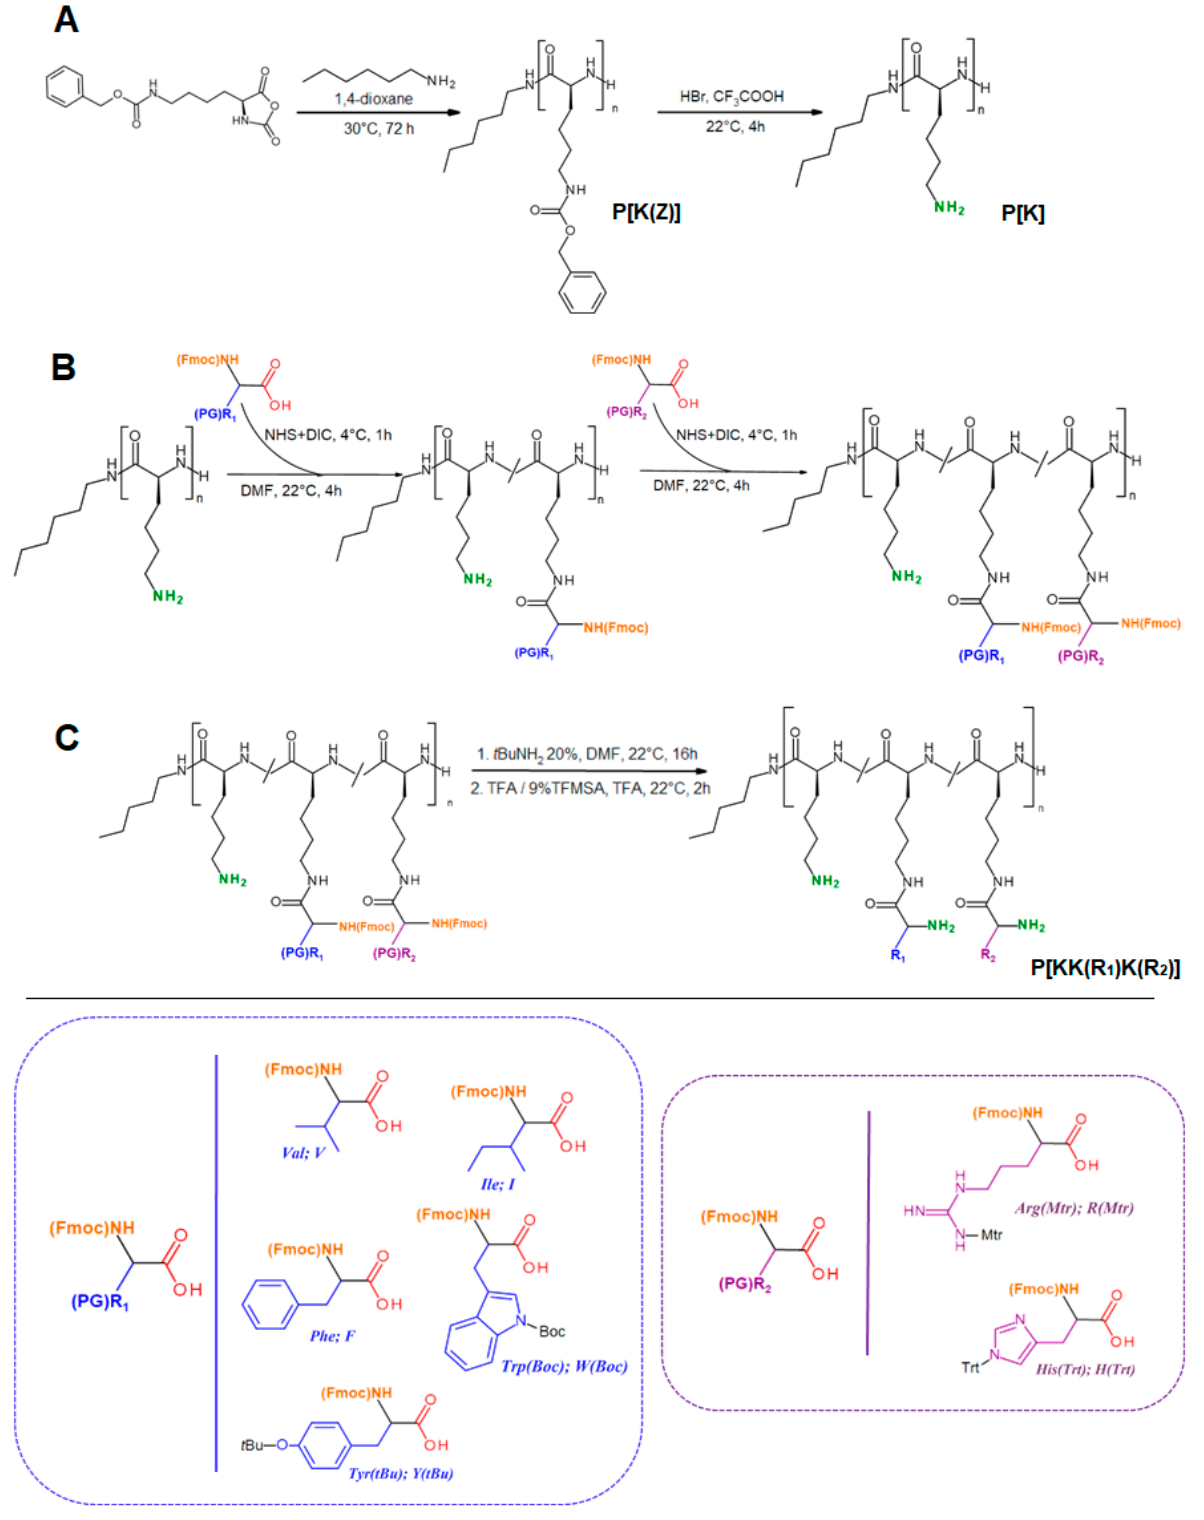
Figure 1. Scheme of the synthesis of cationic amphiphilic polypeptides: ( A ) synthesis of P[K] by ROP; ( B ) post-polymerization modification of P[K] by hydrophobic and basic amino acids; ( C ) deprotection of side chain functional